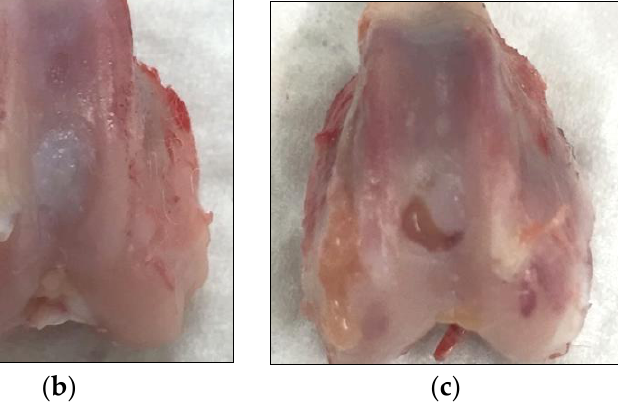
Figure 8. ( a ) Injection of atelocollagen mixed with fibrin into the trochlear defect of a rabbit knee. ( b ) Atelocollagen injection group after 12 weeks. ( c ) Control group without injection after 12 weeks.